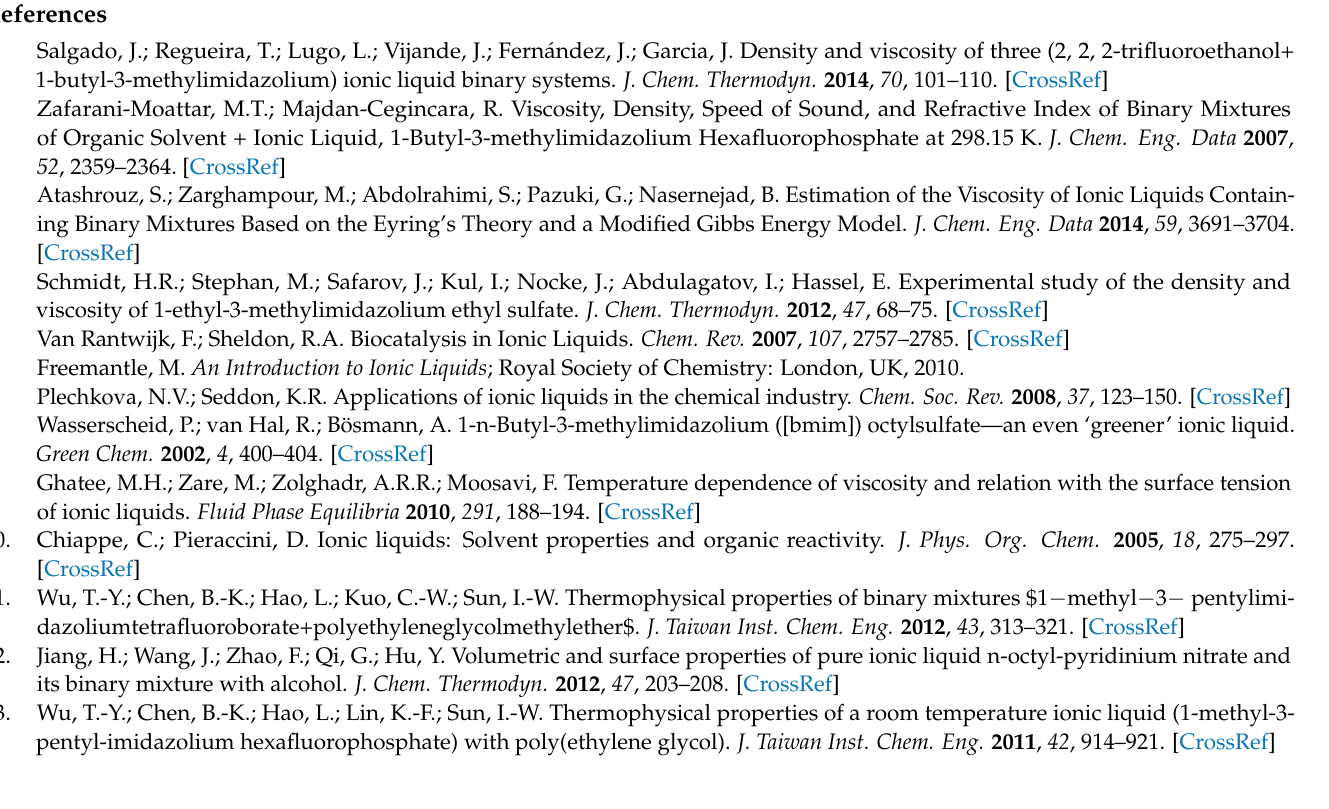
Figure S3: Cross plot of the proposed correlation for viscosity of ILs, Figure S4: Logarithm of experimental viscosity data against predicted values based on Model (II), Figure S5: Relative deviation of predictions of various models versus logarithm of experimental data based on Model (II), Figure S6: Cross plot of the proposed developed models based on Artificial Neural Network based on Model (III), Figure S7: Relative deviation distribution for developed models in this study for estimation of the viscosity of ILs based on Model (III). Table S1: The adjustable parameters to proposed correlation in this